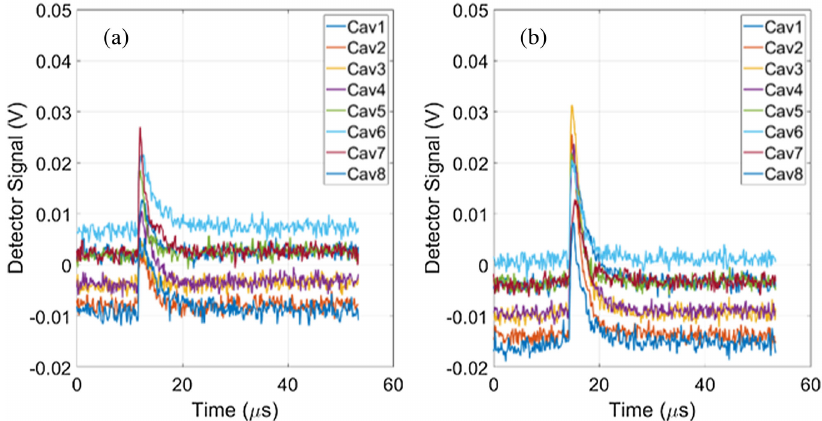
FIG. 11. The output of the SLAC prototype chassis with a single bunch of 10 pC and the beam approximately on axis for (a) US HOMs and (b) DS HOMs (see text). Both cascaded amplifiers are enabled in all channels [8]. We used 300-shot averages and met the experimental objective